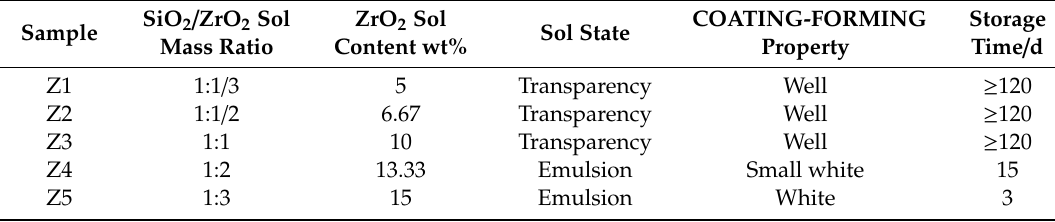
Table 2. SiO 2 / ZrO 2 sol composite-hardened sol solution with di ff erent mass ratio. SiO 2 / ZrO 2 Sol Sample